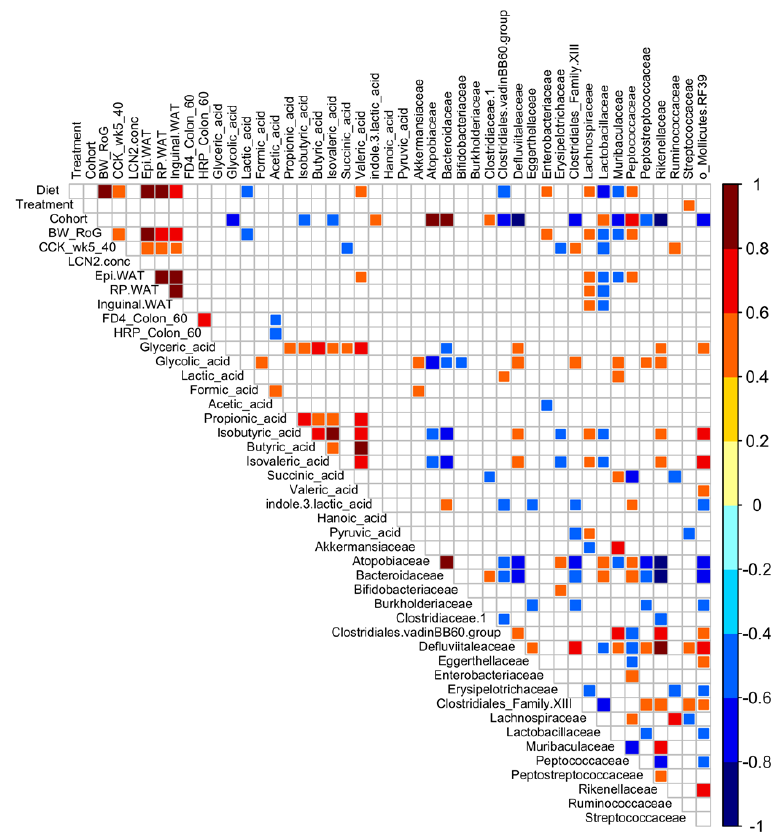
Figure 8. Correlation plot of Spearman’s correlation of project metadata and fecal microbiota. Metadata include body weight rate of gain (BW_RoG), white adipose tissue depot weights (Epidydmal (Epi) and retroperitoneal (RP) WAT), feeding behavior (CCK_wk5_40, CCK food intake at 40 min), intestinal permeability (FD4_colon_60; HRP_colon_60), fecal metabolites, and family-level microbiota. The key experimental variables (diet, treatment, and cohort) are also included for correlation. Colored squares indicate significant correlation. Colored bar at the left provides information about the direction and magnitude of correlation. Uncolored (white) squares demonstrate no significant